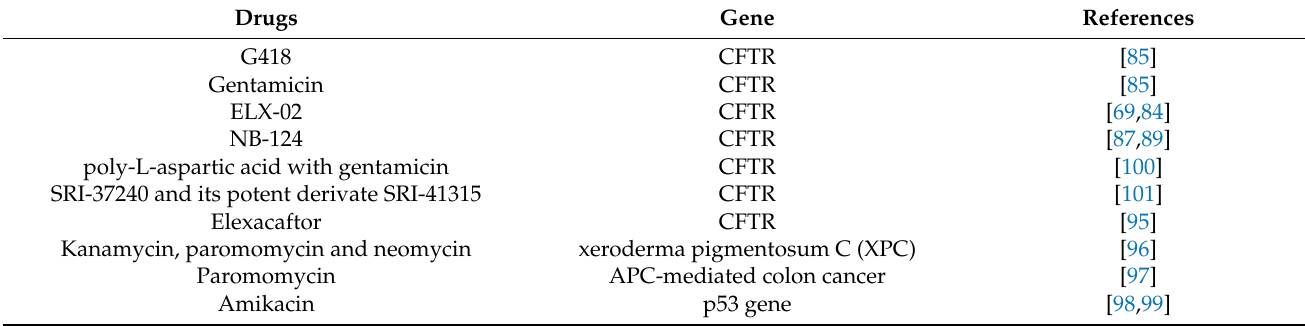
Table 1. Drugs that can suppress and restore gene mutations in different